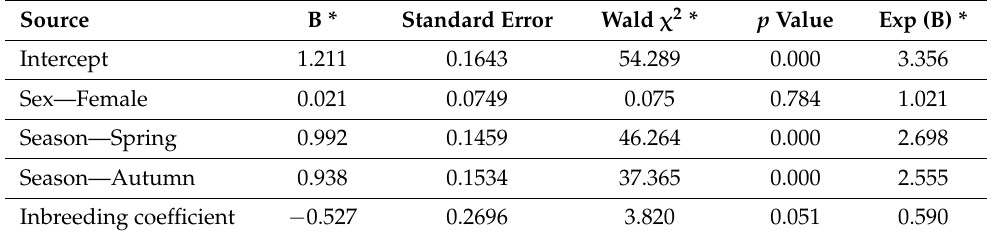
Figure 2. The distribution of inbreeding coefficient within both genetic lines for all animals with known pedigree. Values of inbreeding coefficient were divided into intervals of 2%. The influence of inbreeding, sex and season of birth on survival is presented in Tables 3–5. Table 3. The relationship between the sex, birth season and inbreeding level, and survival to the age of one month for all analyzed animals born between 1946 and 2021 with known pedigree. Males within sex and Winter within season were reference levels, with B value equal to zero.